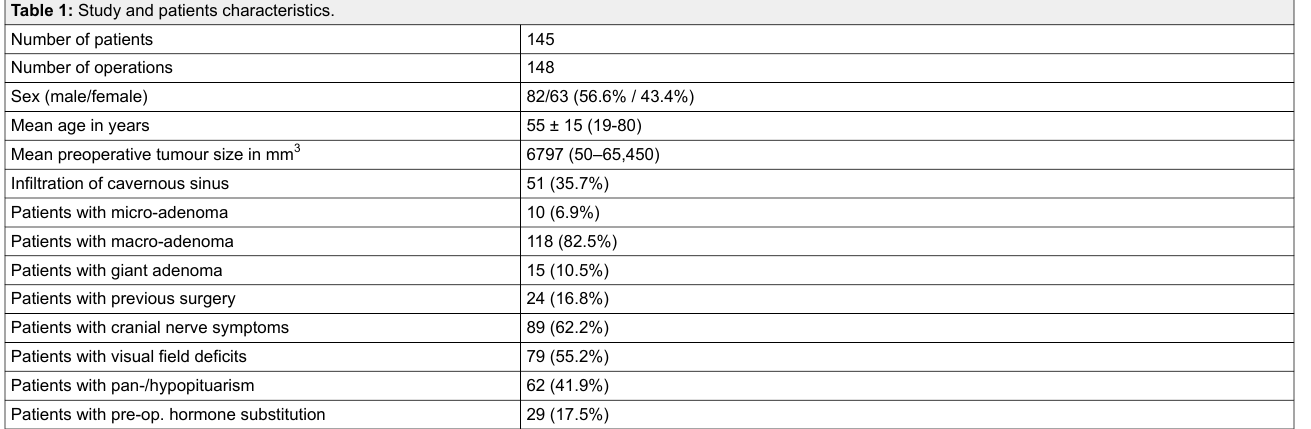
Table 1: Study and patients